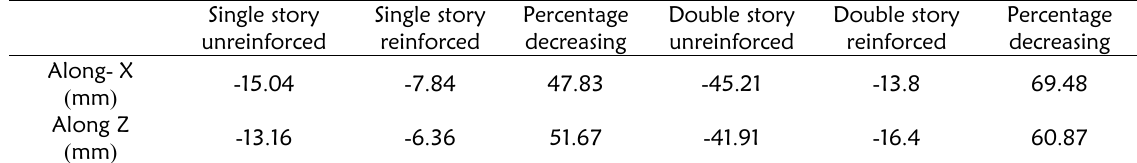
Table 5 : Displacements from time history analysis